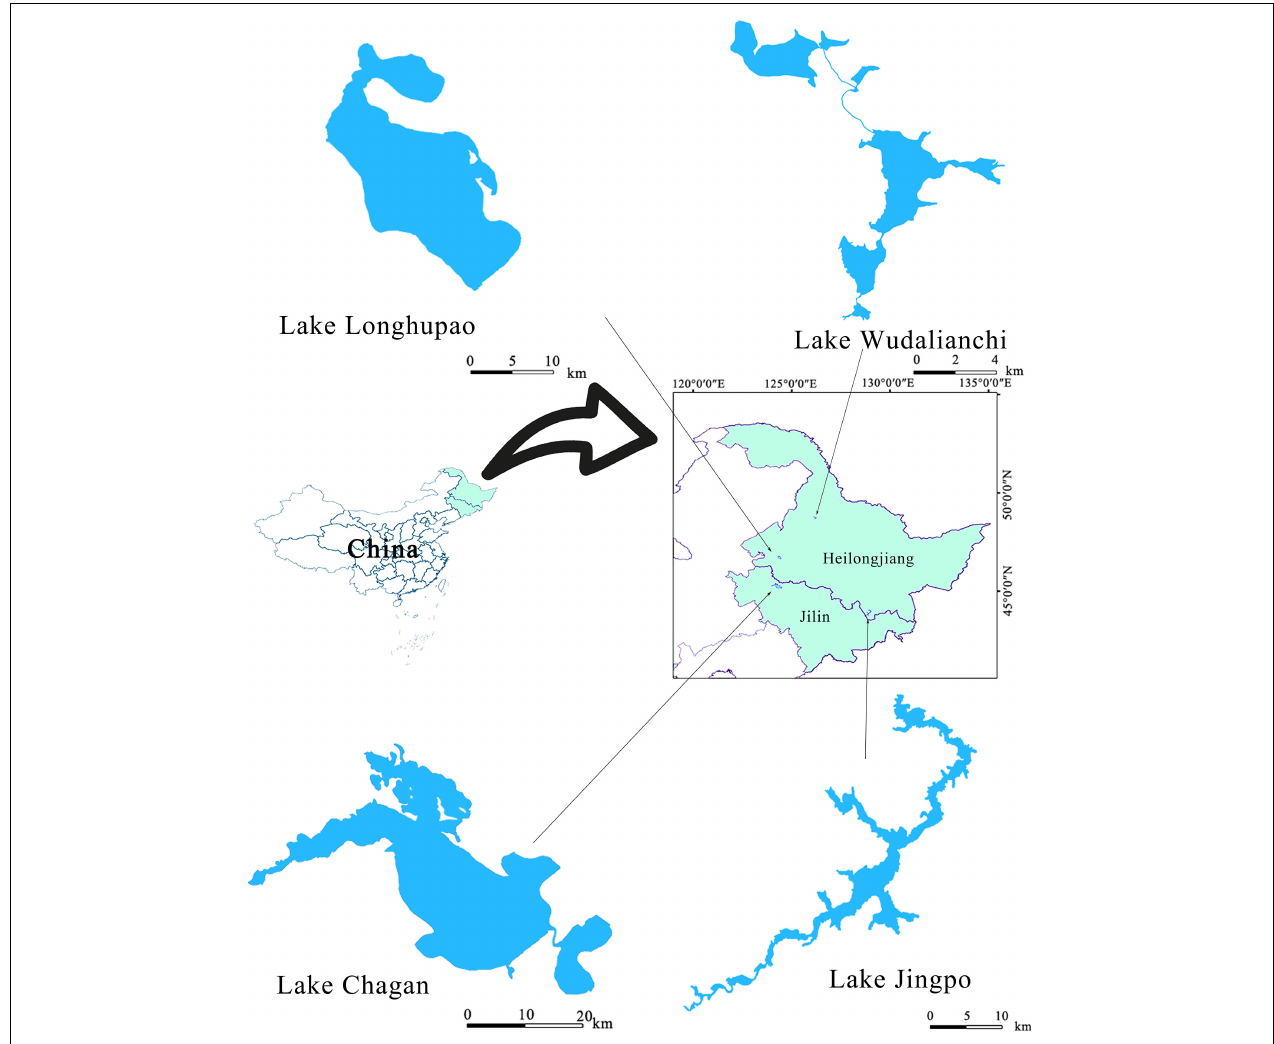
FIGURE 1 | Location of the four selected lakes in Northeast